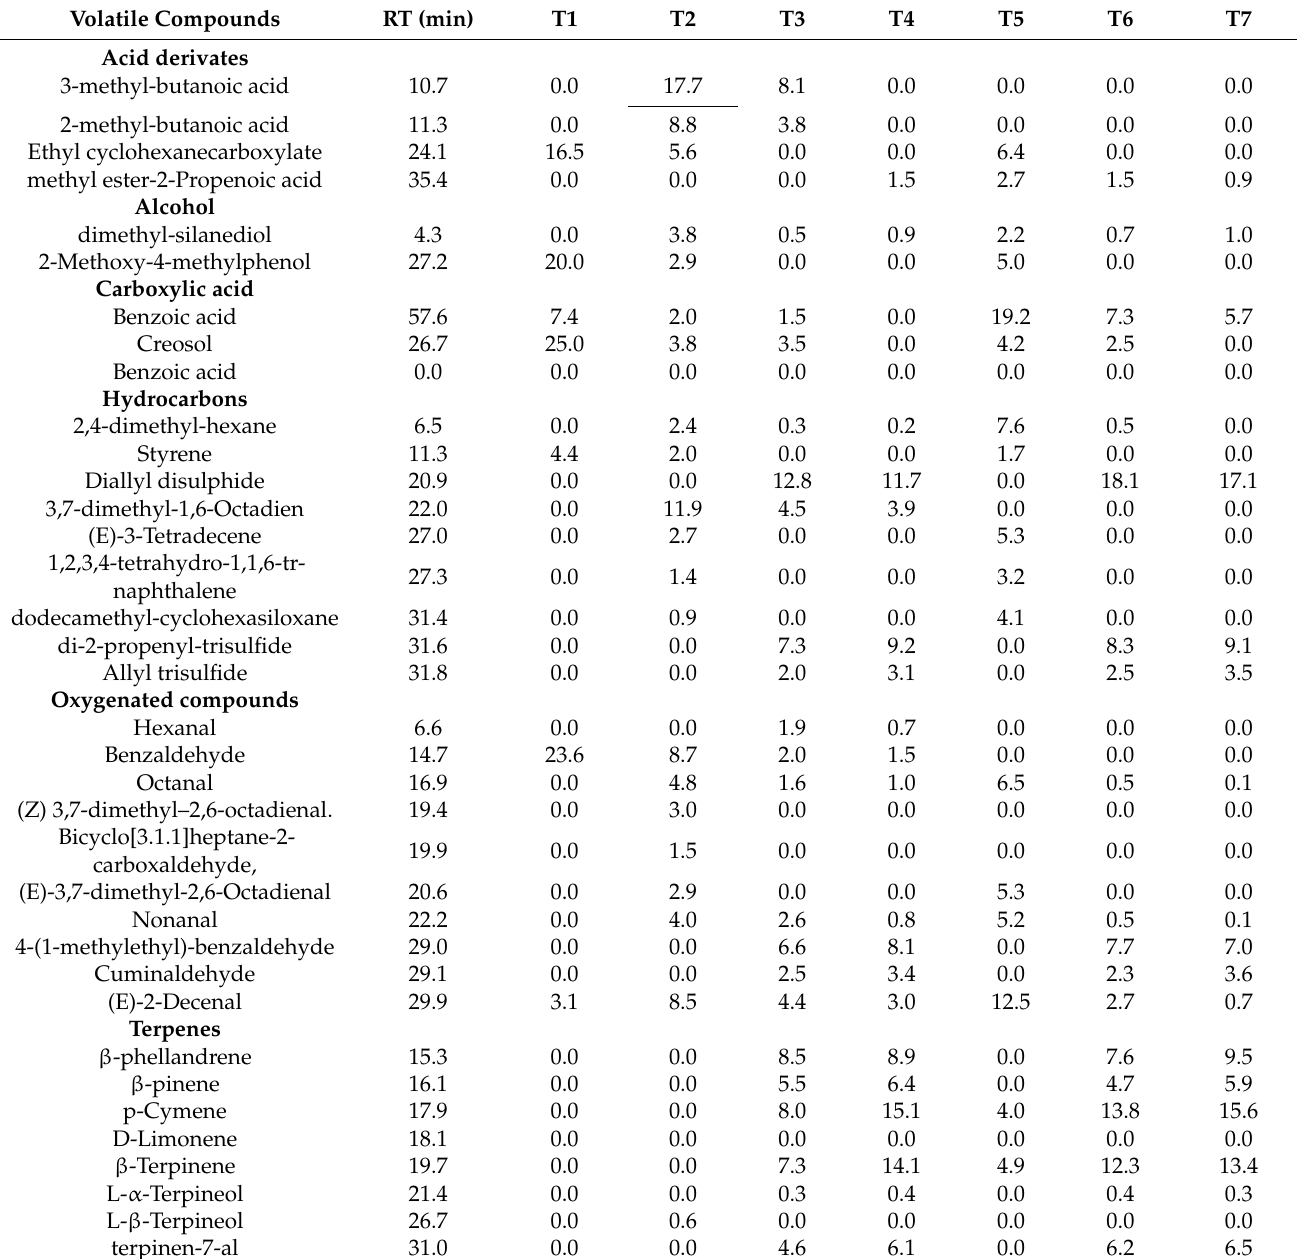
Table 3. Profile of volatile compounds for the different treatments applied to Californian-style black